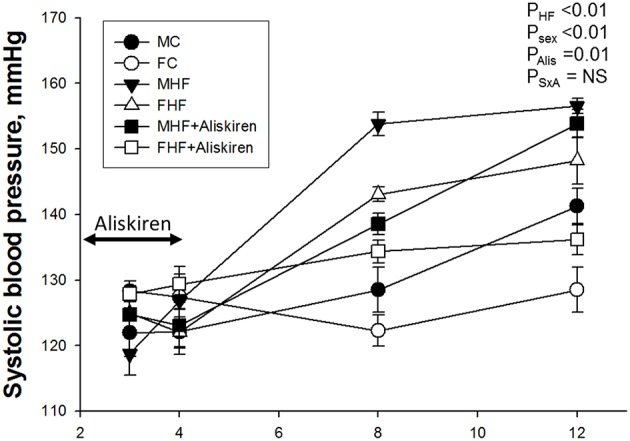
Effect of maternal high-fructose (HF) and aliskiren on systolic blood pressure in male and female offspring. N (pups/litters) = 7/4 per group; Alis = aliskiren; S × A = interaction of sex × aliskiren.